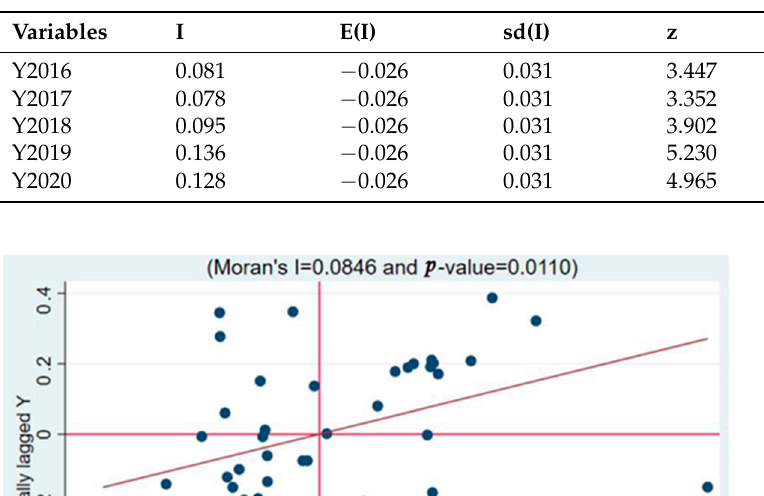
Table 12. Moran test results.